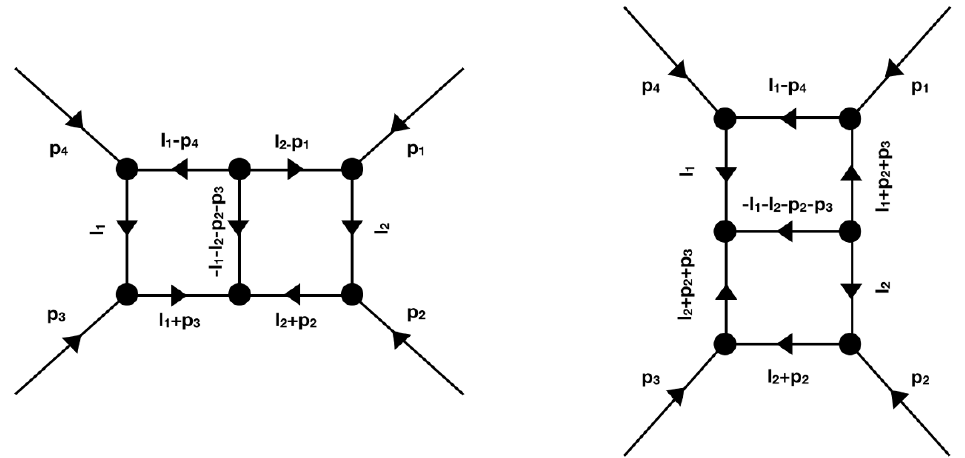
Figure 3 . Two double box integrals parametrised by the set in equation (6.3)